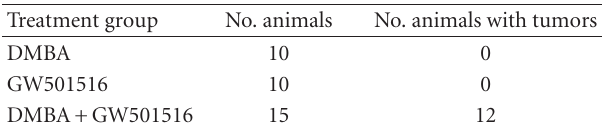
Table 1: Gastric tumor occurrence after treatment with DMBA and